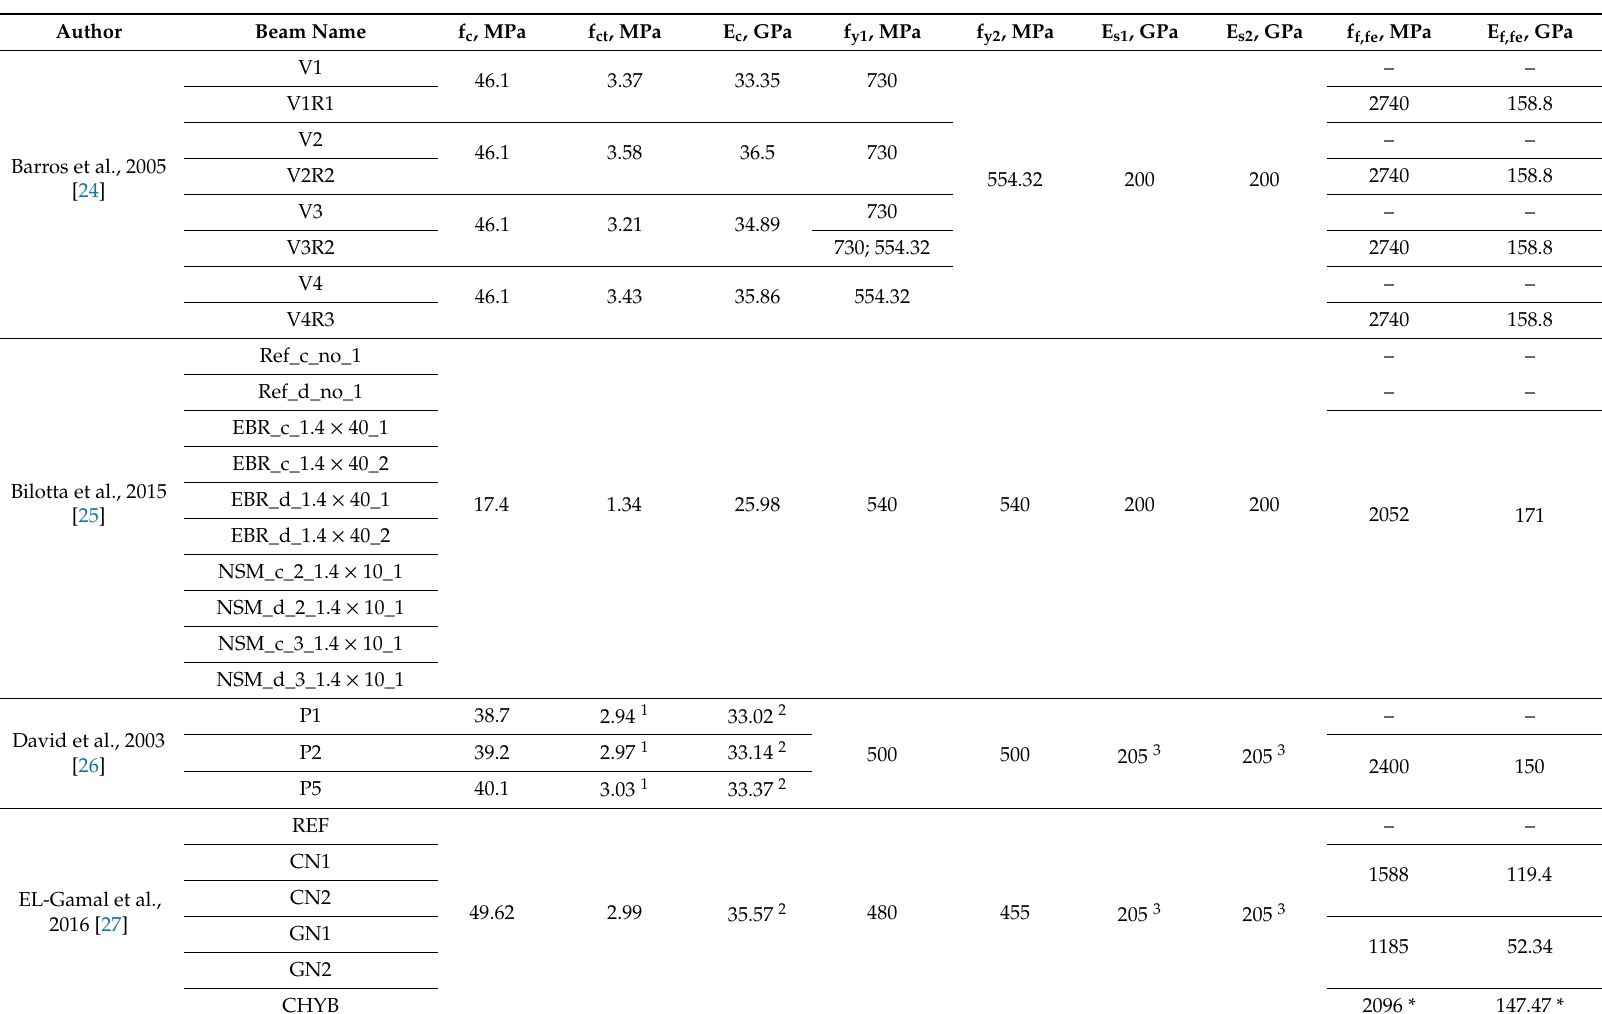
Table 2. Mechanical characteristics of investigated experimental beams